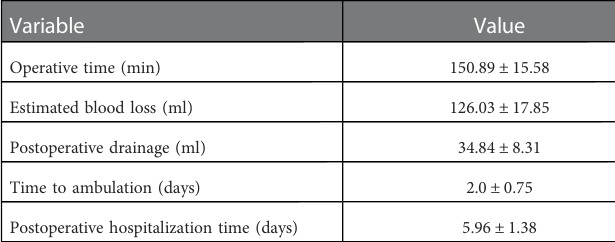
TABLE 1 Demographic and surgical characteristics of included patients.